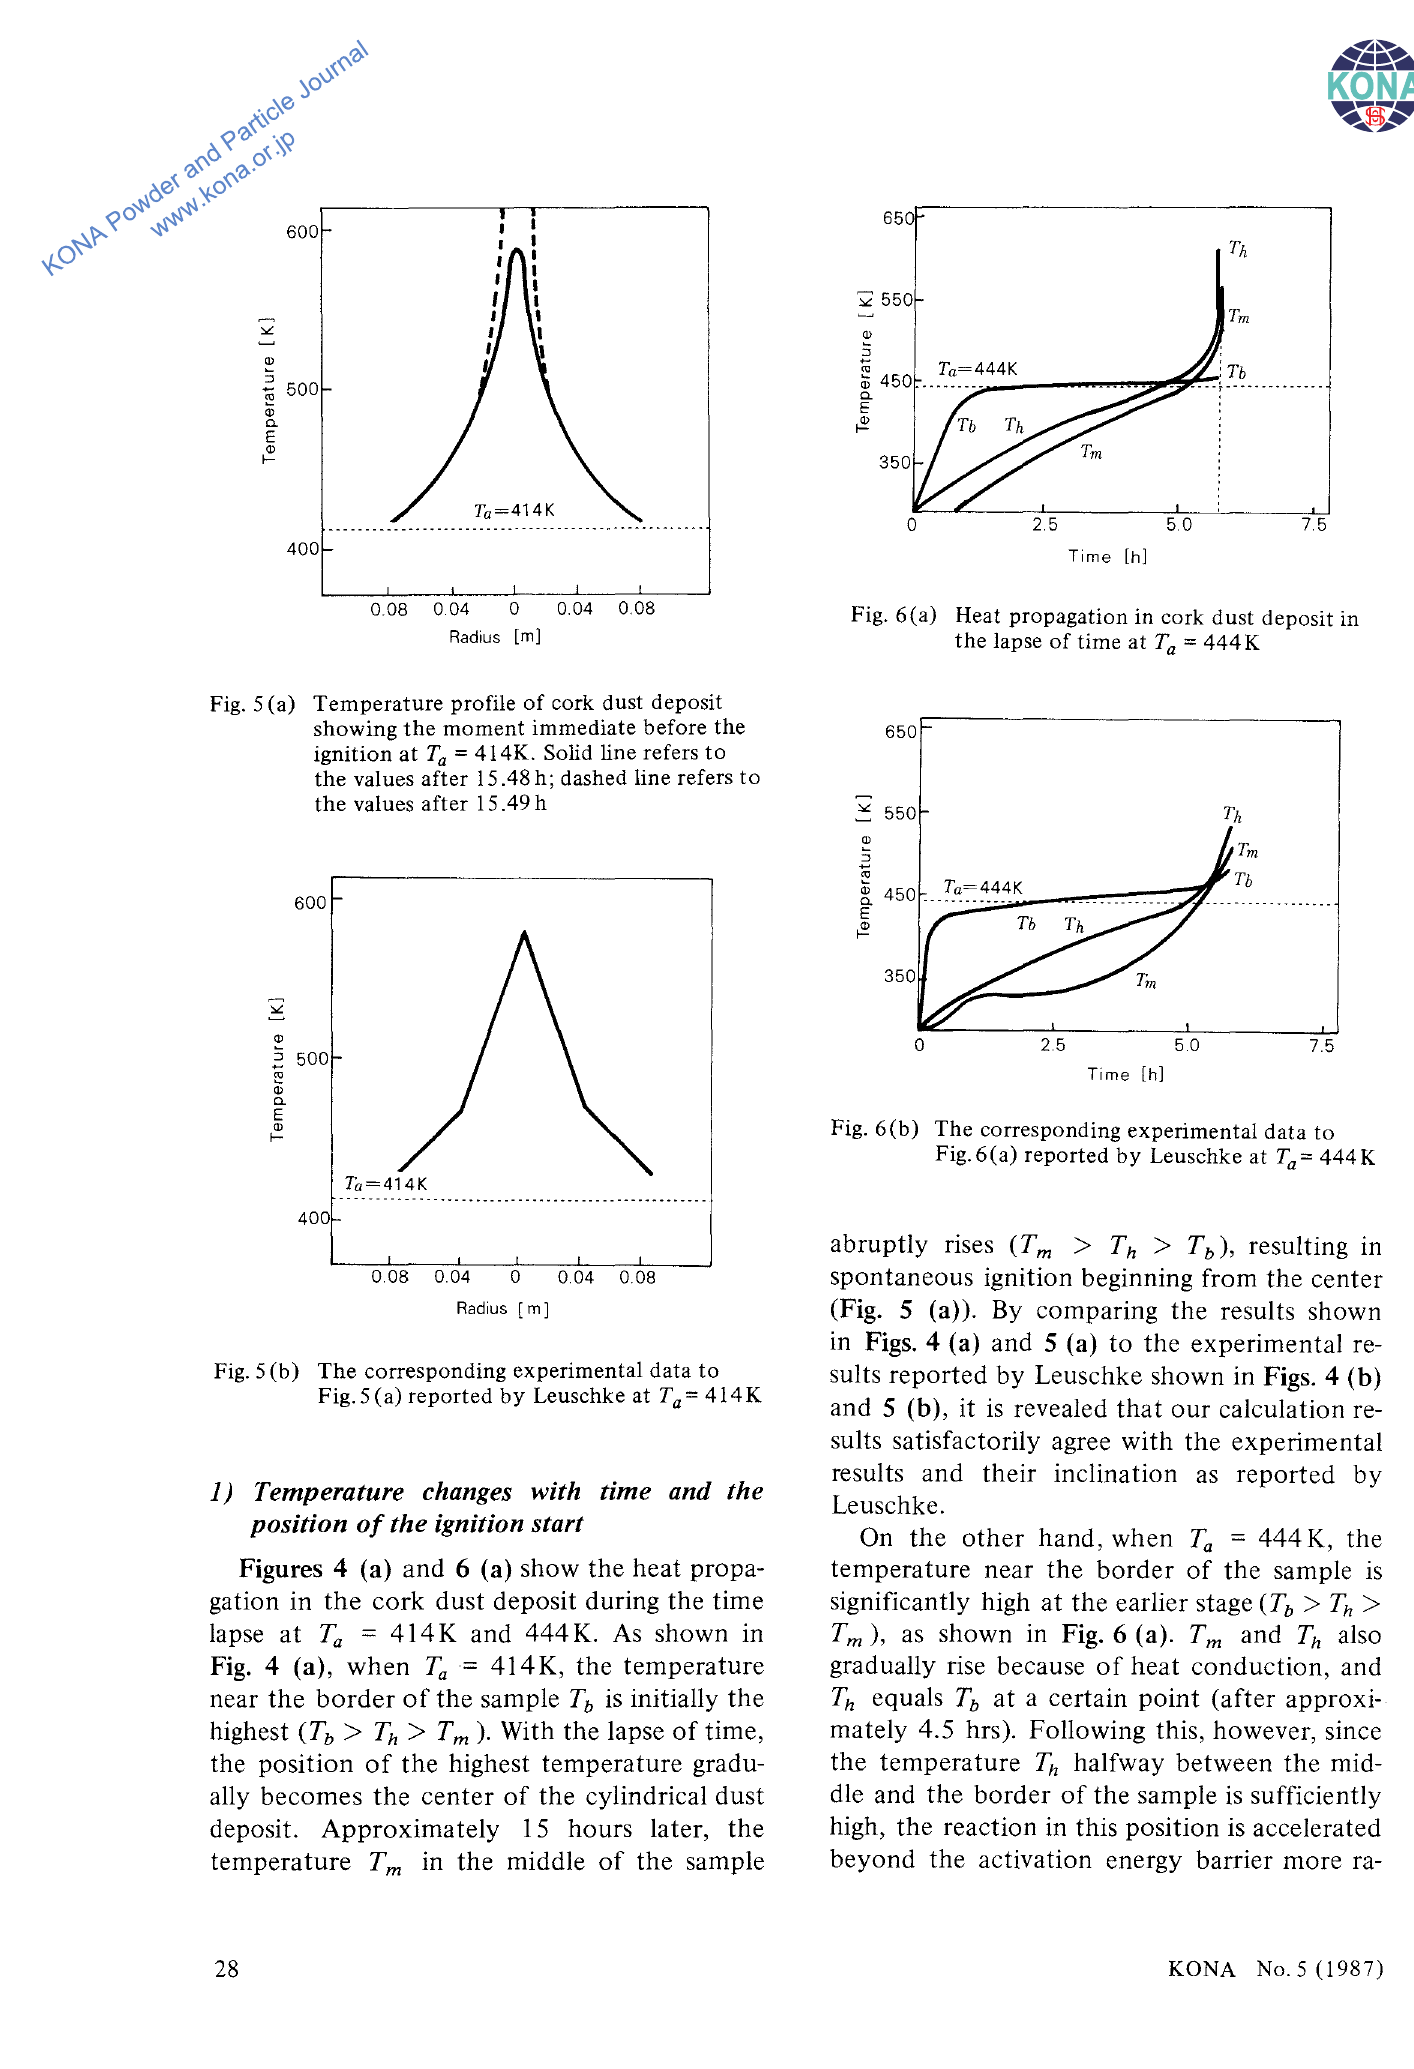
Fig. 6(a) Heat propagation in cork dust deposit in the lapse of time at Ta = 444K